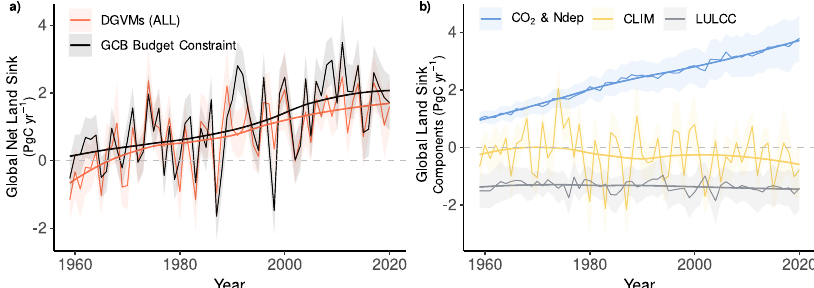
Fig. 1 | Global net land sink and attributionto drivers. a Net annualland carbon sink(PgC yr − 1 ) asestimatedbydynamic globalvegetationmodels(DGVMs) with all drivers varying (red) and the top-down Global Carbon Budget (GCB) constraint (black) and b the decomposition of the DGVM net sink into contributions from